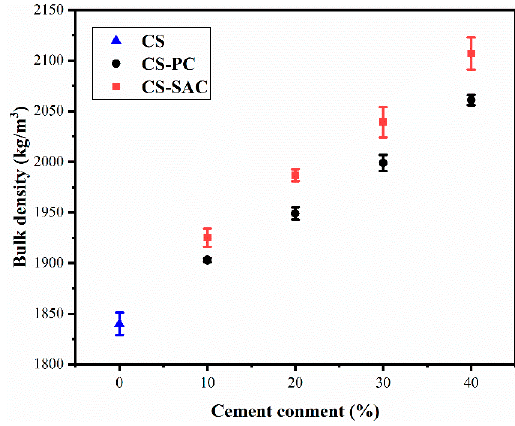
Figure 3. Bulk density of blended mortars at 28 days.